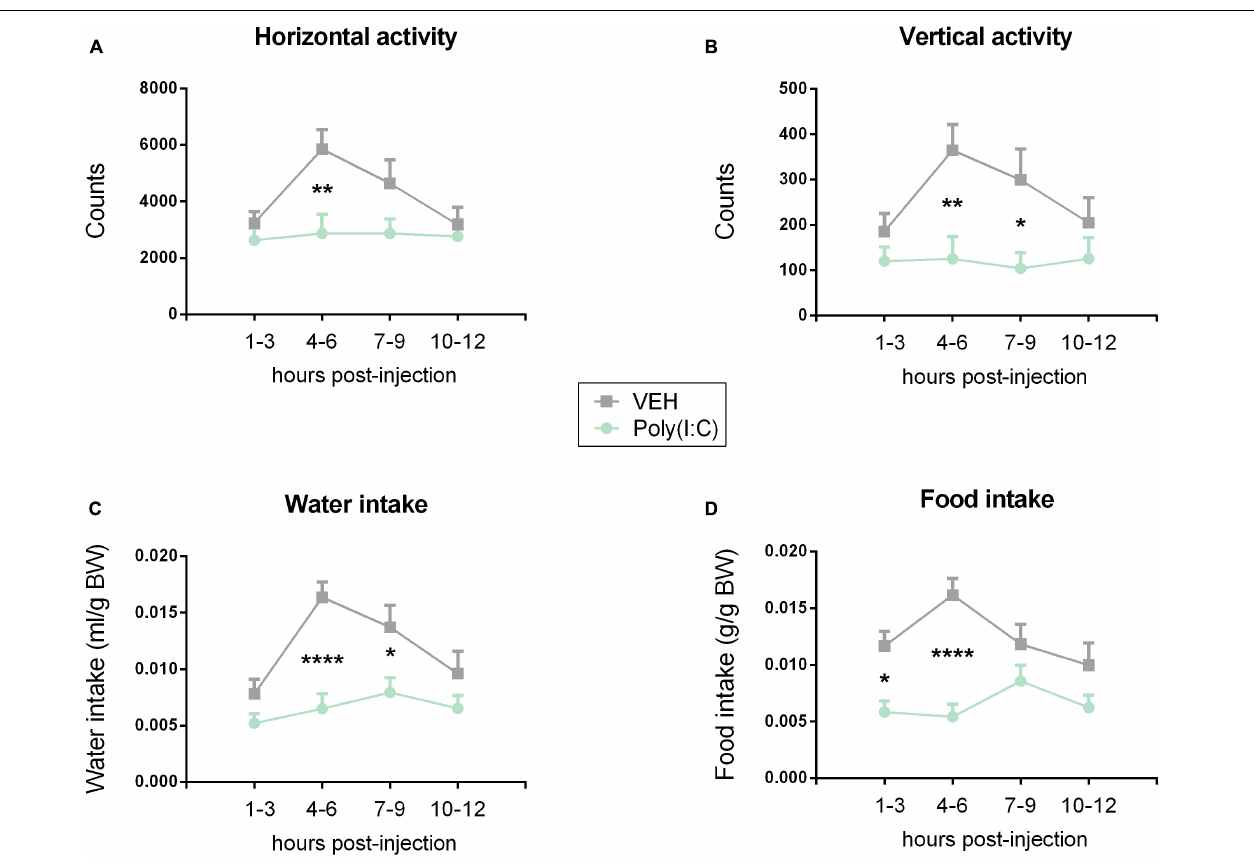
FIGURE 2 | Effect of Poly(I:C) on locomotion (horizontal activity) (A) , exploration (vertical activity, rearing) (B) , water (C) , and food (D) intake. Poly(I:C) (12 mg/kg) or vehicle (VEH) was injected i.p. at 0 h, and the test parameters were recorded at the subsequent time intervals shown. Values represent means + SEM, n = 6. Results of RM two-way ANOVA: F (3, 102) = 2.559, p = 0.0592 for interaction of time/treatment in locomotion; F (3, 102) = 3.400, p ≤ 0.05 for main effect of time on locomotion; F (1, 34) = 6.412, p ≤ 0.05 for main effect of i.p. treatment on locomotion; F (3, 102) = 1.992, p = 0.1199 for interaction of time/treatment in exploration; F (3, 102) = 1.855, p = 0.142 for main effect of time on exploration; F (1, 34) = 10.31, p ≤ 0.01 for main effect of i.p. treatment on exploration; F (3, 102) = 2.661, p = 0.0521 for interaction of time/treatment in water intake; F (3, 102) = 5.135, p ≤ 0.01 for main effect of time on water intake; F (1, 34) = 27.12, p ≤ 0.0001 for main effect of i.p. treatment on water intake; F (3, 102) = 3.256, p ≤ 0.05 for interaction of time/treatment in food intake; F (3, 102) = 1.730, p = 0.1656 for main effect of time on food intake; F (1, 34) = 26.87, p ≤ 0.0001 for main effect of i.p. treatment on food intake. Results of Bonferroni’s multiple comparison post hoc